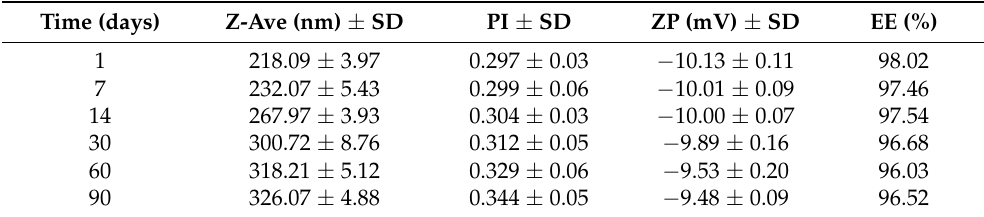
Table 8. Physicochemical stability of PF-NLCs-N6 at 25 ◦ C ( n = 3), monitored by the evaluation of any change in the following parameters: mean particle size, polydispersity index, zeta potential and encapsulation efficiency.